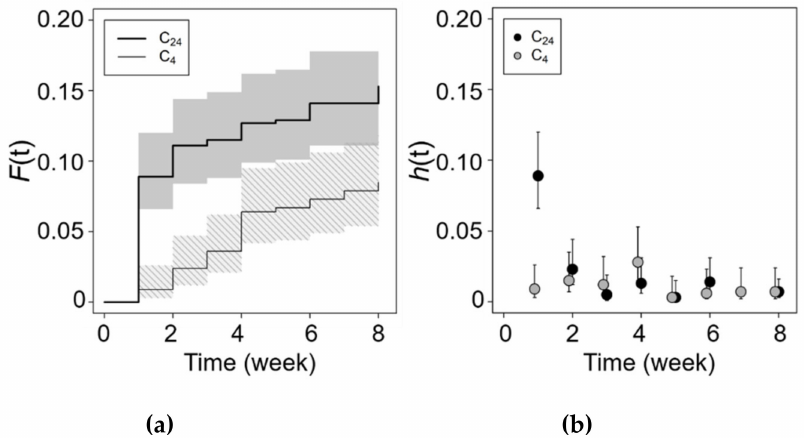
Figure 2. Germination test; chilling treatments (C 24 and C 4 ) averaged over common salinity levels (N 1 , N 50 and N 150 ). ( a ) germination probability, F (t); ( b ) hazard rate, h ( t ). Mean ± 95% CI bands or bars calculated by boot.ci() function in (cid:48) boot (cid:48) R package. Values of h ( t ) = 0 (no germination) were not reported (e.g., C 24 at week 7).